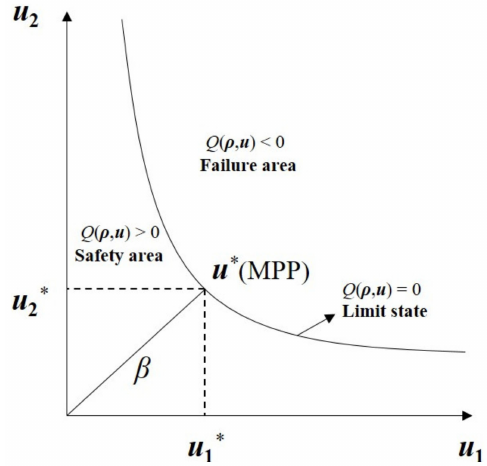
Figure 2. Geometric description of reliability index in standard normal